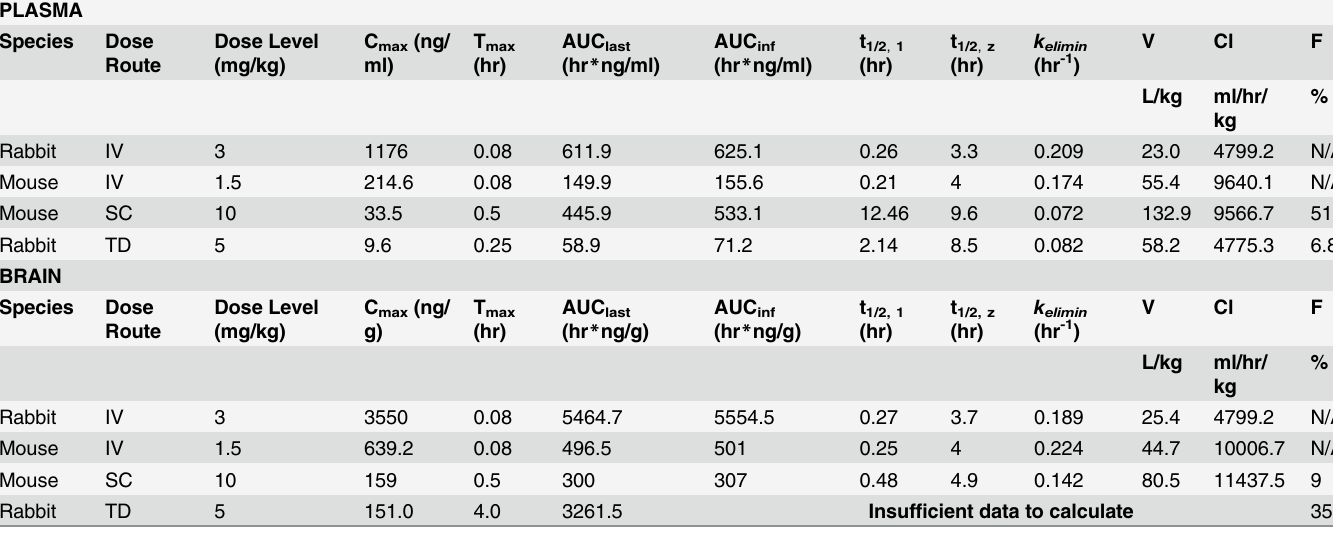
Table 1. Pharmacokinetic parameters for allopregnanolone in both rabbit and mouse. PLASMA Species Dose Route